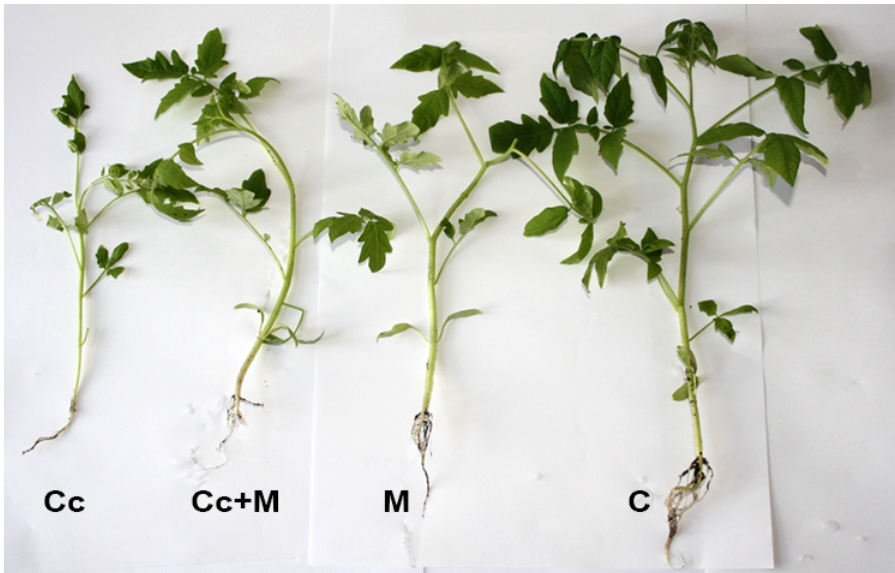
Fig. 3 Tomato seedlings grown with the pathogenic fungus (isolate PER14), mycorrhiza, and in the control groups. For description of abbreviations, see Tab. 1.